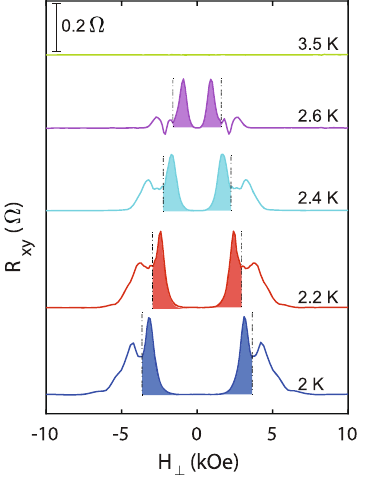
valuesfor allthe samples.The temperatures are:7.0 K ,2.4K,2.0 K, 2.2K,2.3Kand 2.6 K for thin fi lms Nb(38)/YIG, Bi 2 Pd(50)/Si, Bi 2 Pd(50)/YIG, Bi 2 Pd(70)/YIG, Bi 2 Pd(85)/YIG and Bi 2 Pd(300)/YIG, respectively. 10 μ A d.c. current was applied in- plane. All the magnetic fi elds are applied perpendicular to the fi lm plane. The dot- dashed lines correspond to the critical fi elds (H c 2